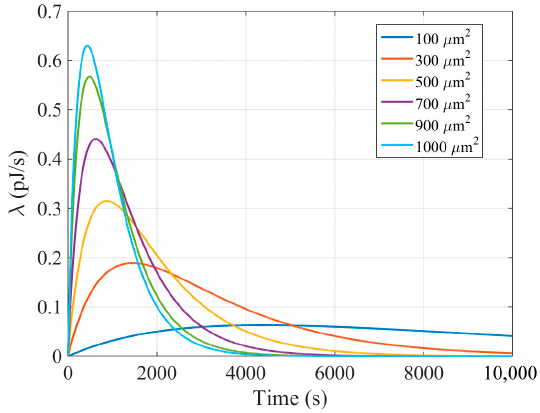
Figure 3. Energy-harvesting rate as a function of time for different nanogenerator areas.